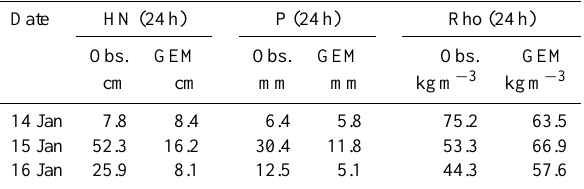
4 Snow cover stratigraphy simulation Bellaire et al. (2011) compared an observed snow cover pro-